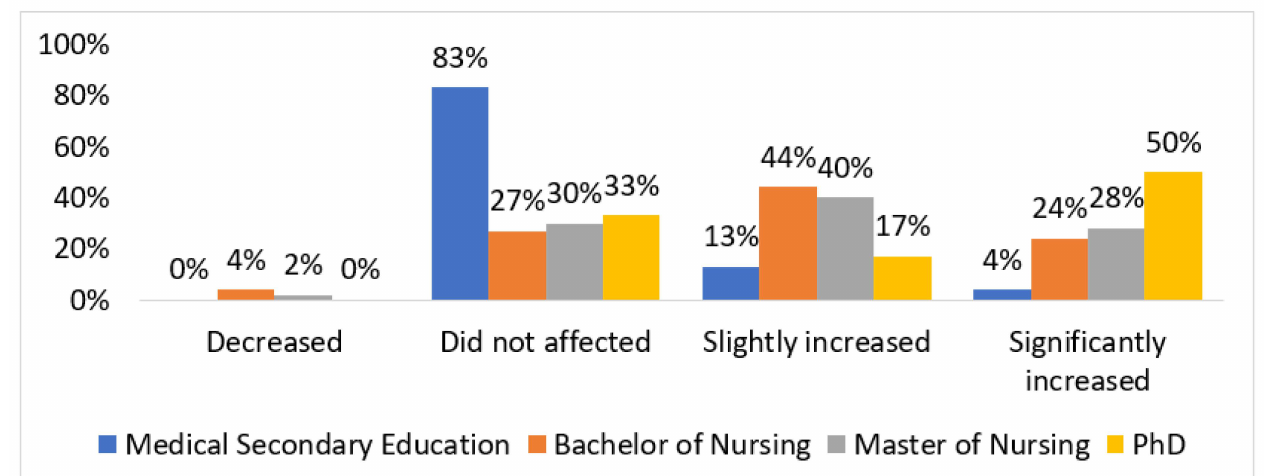
Figure 1. The impact of the COVID-19 pandemic on the level of professional independence depending on education.